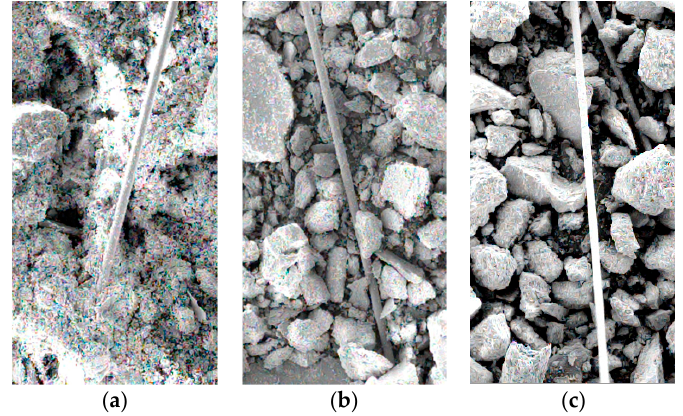
Figure 17. SEM images of fiber monofilaments in BFRT specimens. ( a ) Fiber-reinforced tailings clay, ( b ) fiber-reinforced tailings silt, ( c ) fiber-reinforced tailings sand. ( b ) fiber-reinforced tailings silt, ( c ) fiber-reinforced tailings